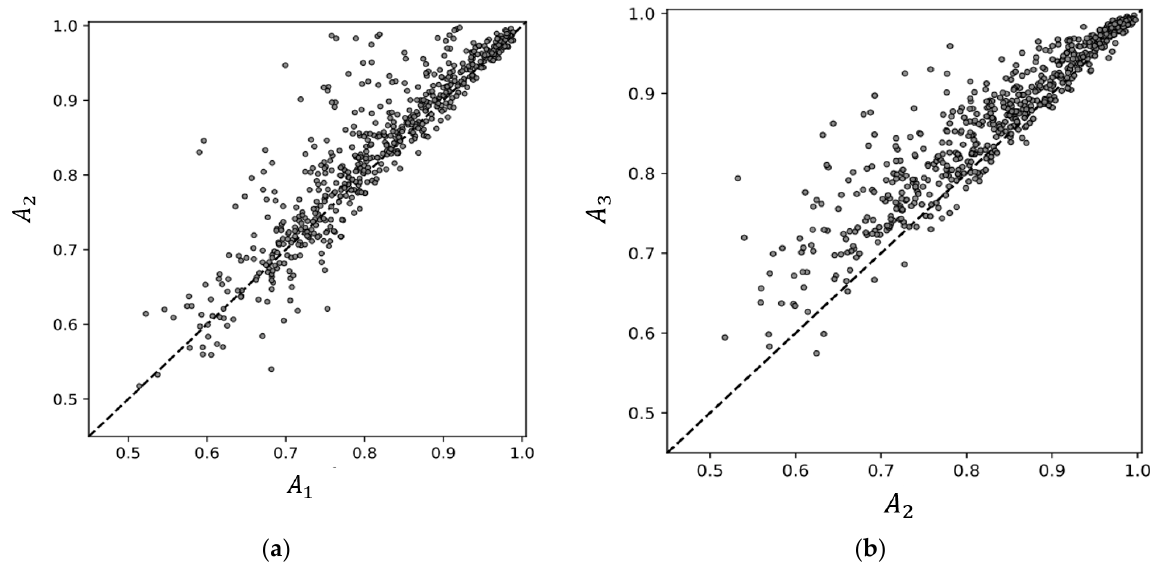
Figure 2. Comparison between the performances of different algorithms; ( a ) the comparison re- sults of LDA and linear SVM; ( b ) the comparison results of linear SVM and non-linear